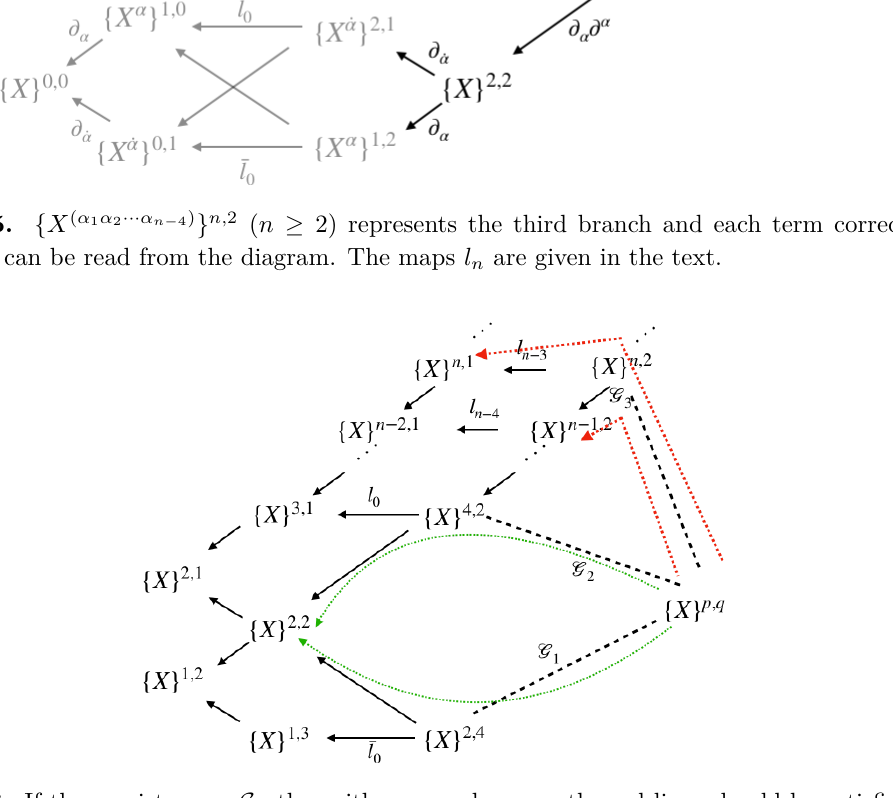
Figure 6. If there exist maps G i , then either green loops or the red lines should be satisfied such that { X } p,q meets the criteria of being a correction